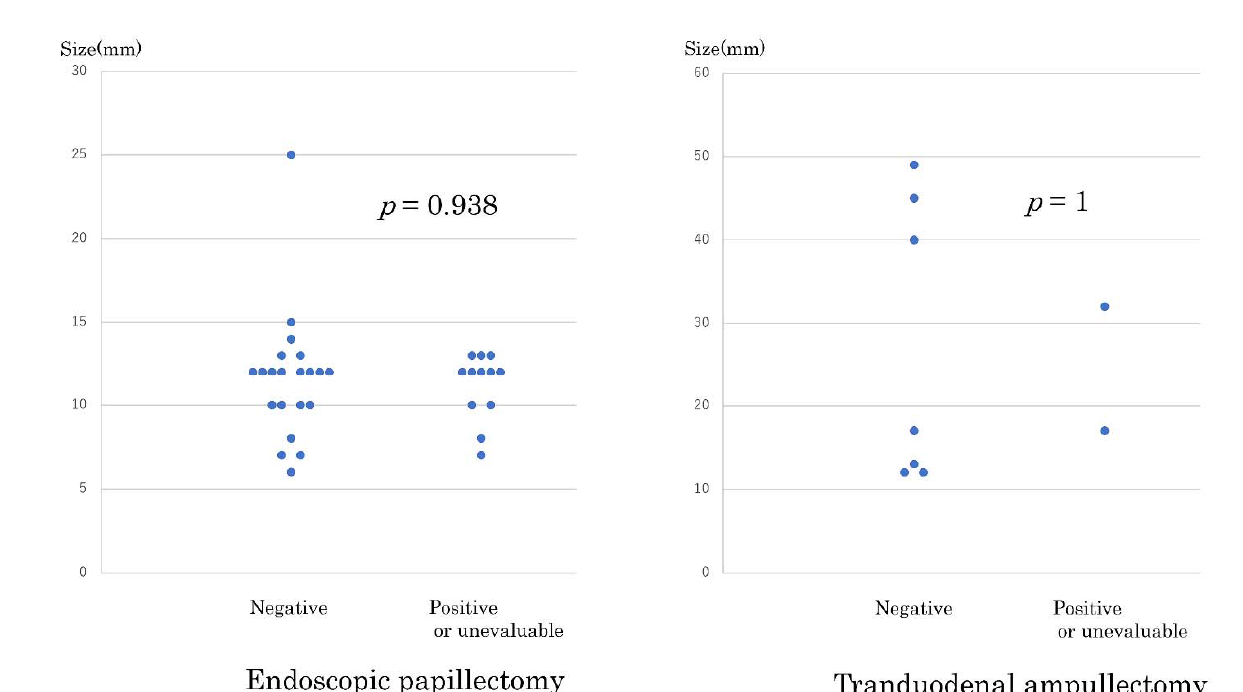
Figure 2. Distribution of tumor sizes related to negative and positive/unevaluable margins. EP (endoscopic papillectomy) ( left ), TDA (transduodenal ampullectomy) ( right ).